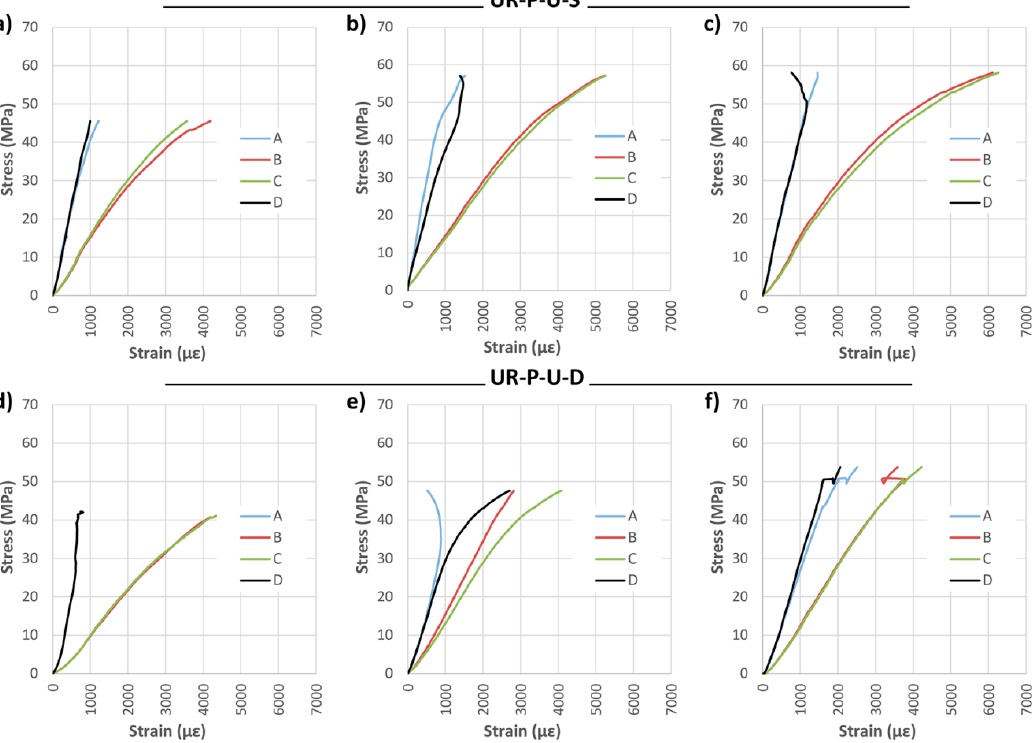
Figure 21. Stress against strain during bending tests: ( a ) UR-P-B-D-1; ( b ) UR-P-B-D-2; and ( c ) UR-P-B-D-3. CFRP supplier: DRIZORO ® . 5.5. Comparison Between the Different Reinforcement Groups Once a detailed analysis of the different layouts had been carried out individually, a general comparison was depicted, in Figures 22 and 23, to represent the average MOR and corrected MOR. The horizontal red line indicates the average MOR for the non-reinforced beams. As deduced from Figure 22, a comparison of different layouts by the mean MOR values, without taking into account any density correction factors, may lead to an incorrect analysis. Figure 23 shows how the introduction of this density correction factor makes the different groups comparable in a more objective and rigorous form. This is due to the major differences in terms of density and defects of each particular beam. In the case of LR beams, a look at Figure 23 shows no great differences between a partial or total width reinforcement. Previous works have stated that the strengthening depends on the area of reinforcing material. However, delamination is the main